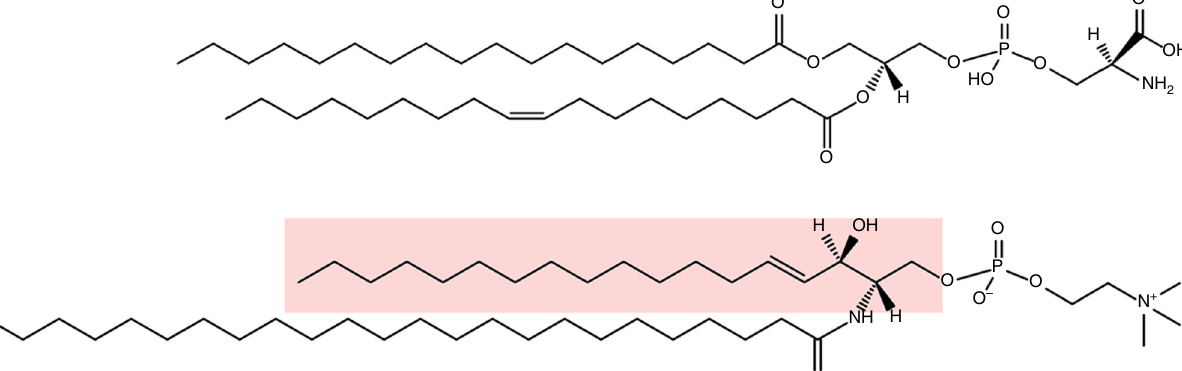
Fig. 1 Structures of glycerophospholipids and sphingolipids. The lipids shown are PS 18:0/18:1 (top) and SM d18:1/24:0 (bottom). Different head groups are giving rise to the various lipid classes (Table 1) and different fatty acyl groups result in various species within the class. Note that sphingolipids often contain N-amidated fatty acyl groups much longer than those most common in glycerophospholipids. The sphingoid base of SM d18:1/24:0 is highlighted in red. It should be noted that the double bond C18:1 (oleic acid) is in cis con fi guration and that the double bonds of all fatty acyl groups of phospholipids and sphingolipids have a cis con fi guration. The structures have been made by using the structure drawing tools available at Lipid Maps (www.lipidmaps.